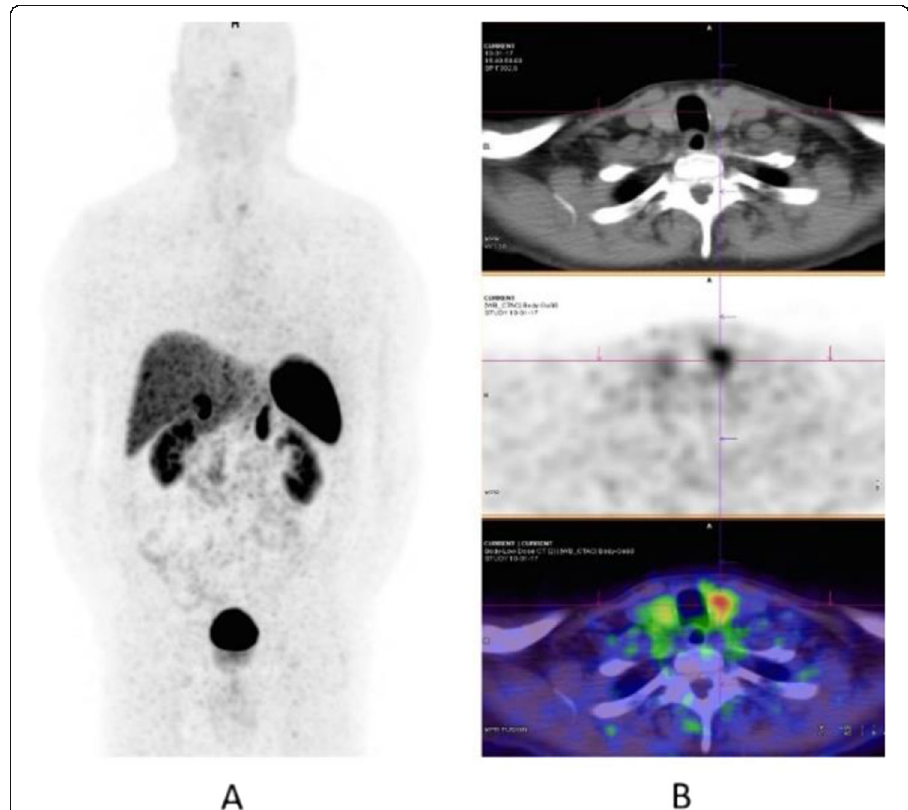
Fig. 62 68Ga-DOTA peptide, staging medullary thyroid cancer (MTC). Clinical history : 70 y.o. man with newly diagnosed MTC. Suspicion of distant metastases on CT. PET/CT findings : moderately increased uptake in the known tumour ( a MIP, b CT, PET, and fused imaging). No other suspicious lesions are seen